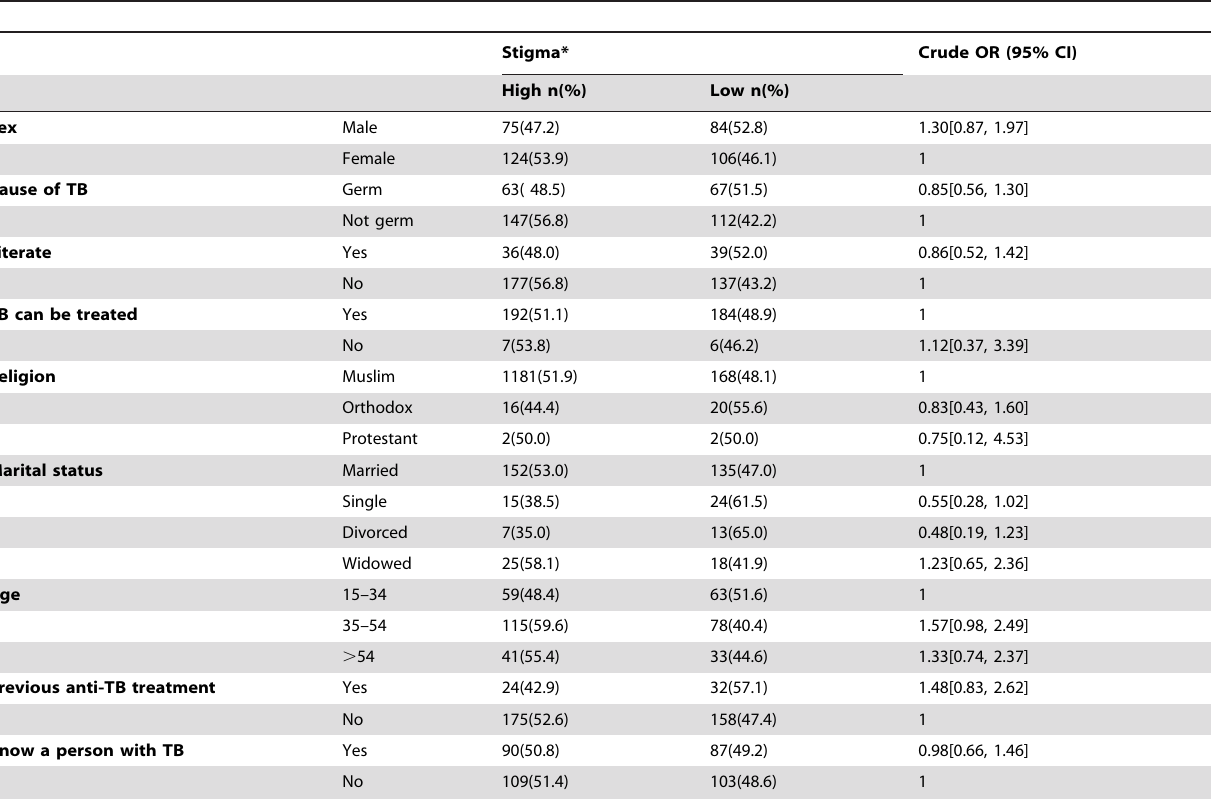
Table 5. Factors associated with stigma towards TB among TB suspects (n =389) in the Gilgel Gibe field research area, south west Ethiopia, March